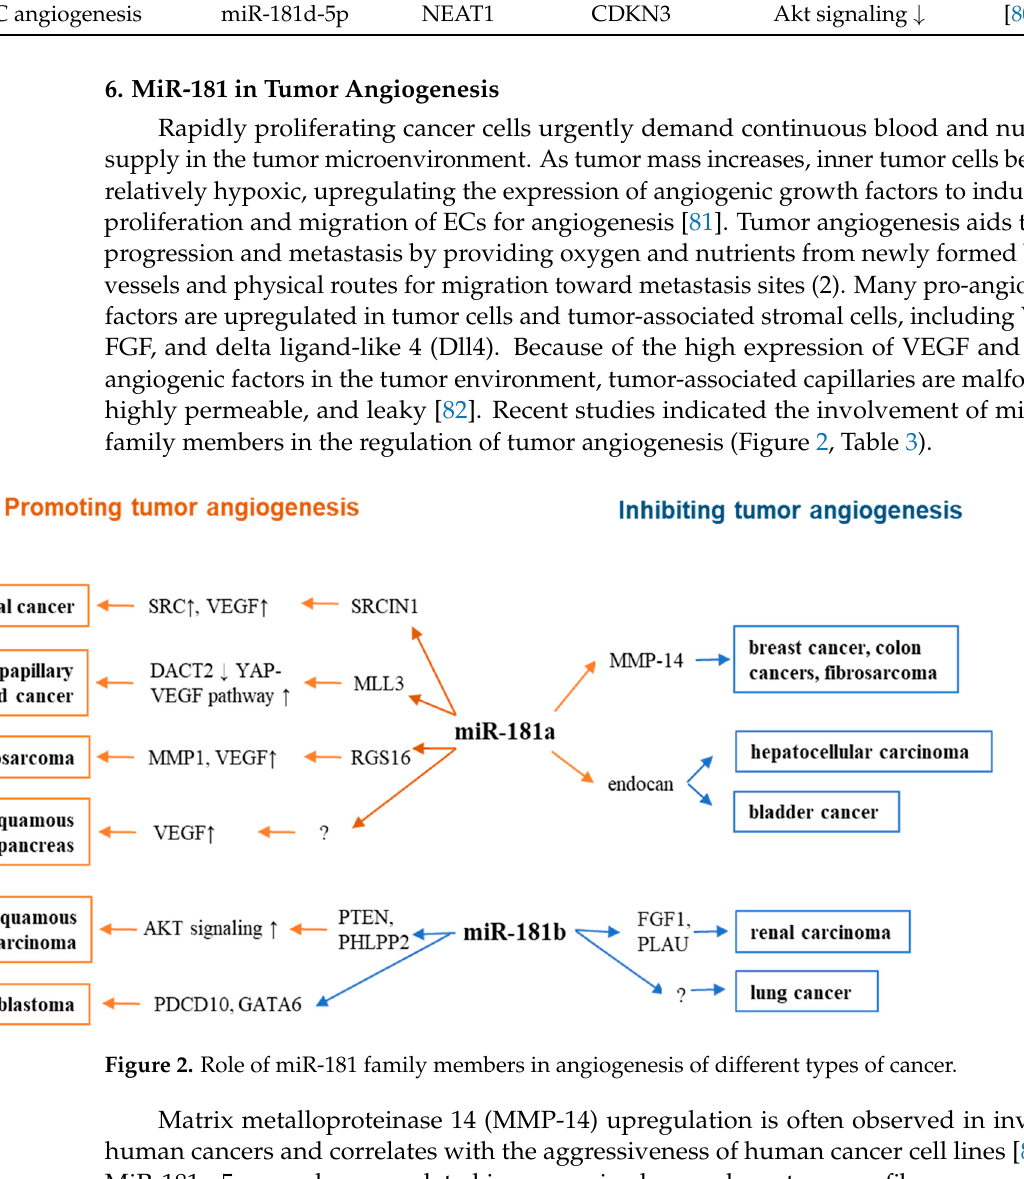
Table 3. Roles of miR-181 in tumor angiogenesis.